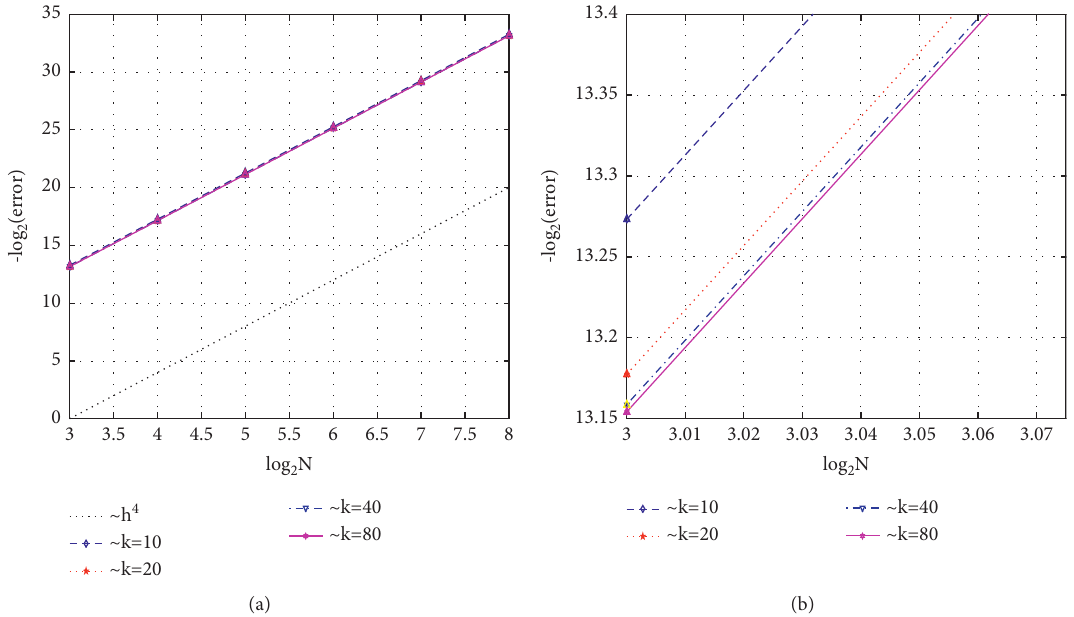
Figure 7: (a) Error curves for Example 1 with k � 10 , 20 , 40 , 80. (b) A local part of